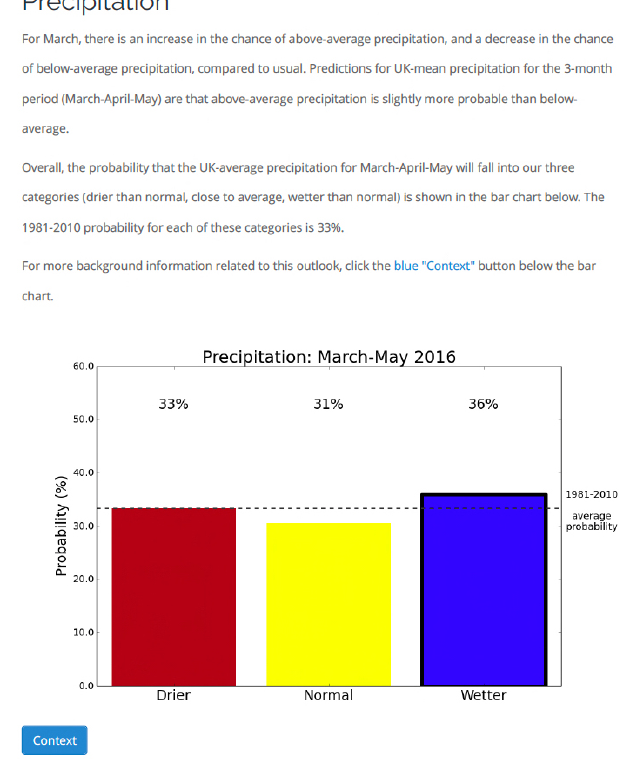
Figure 2. Seasonal climate forecast for precipitation for March– May 2016 provided to the farmers through the microsite.